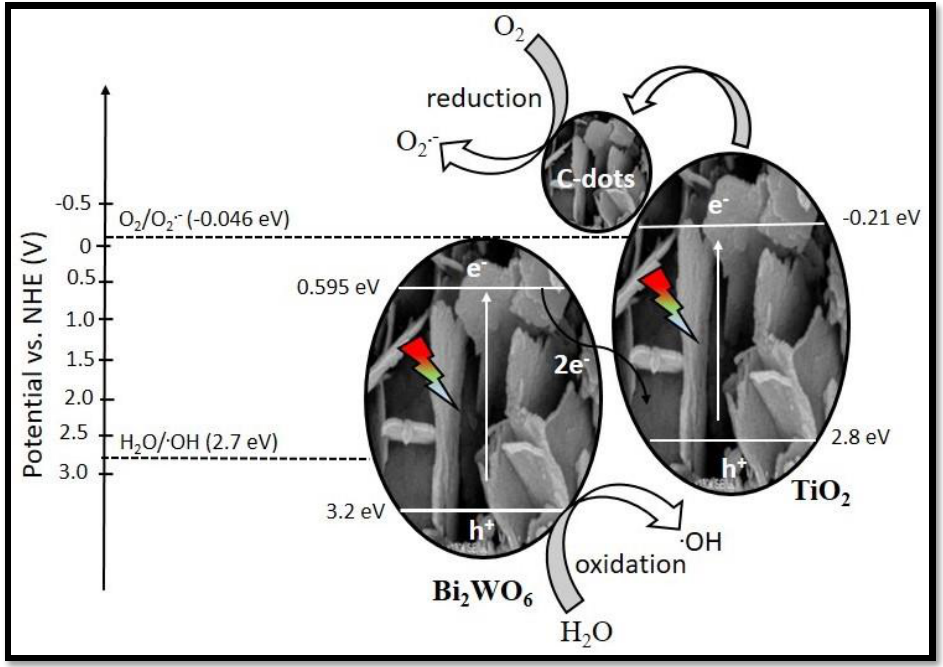
Figure 8. Plausible mechanism of photocatalytic degradation of levofloxacin with Z-scheme photocatalyst.